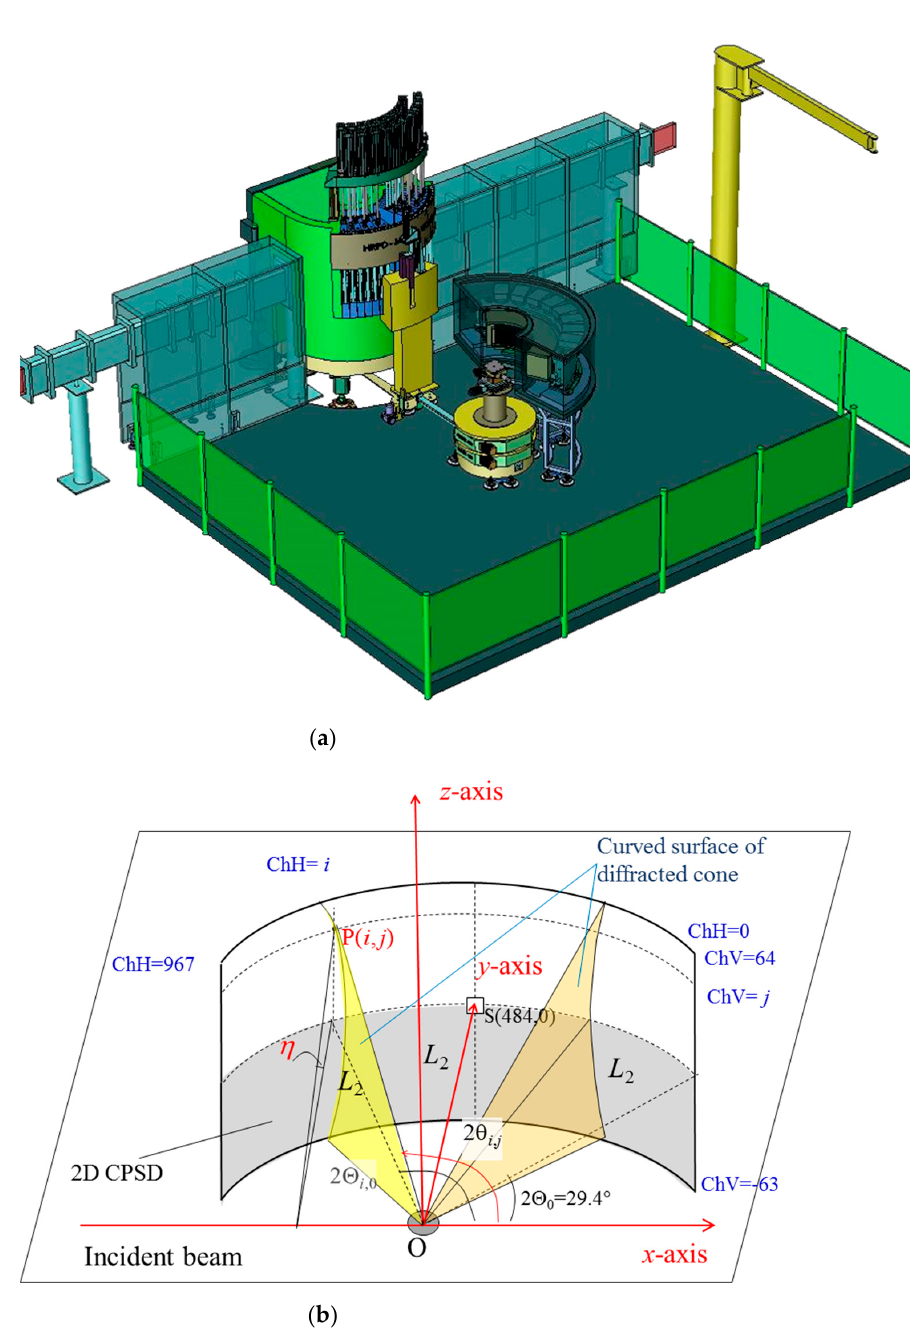
Figure 3. ( a ) Layout of WOMBAT, and ( b ) illustration of a two-dimensional cylindrical position-sensitive detector and the axis convention of an arbitrary pixel P( i , j ) → P( x , y, z ) → P(2 θ , η ) for both Cartesian lab space and angular coordinate systems, here at an offset angle of 2 Θ 0 = 29.4°. ( i , j ) are the channel numbers (ChV, ChH) of an arbitrary pixel position along the vertical and horizontal directions, respectively. The current setting with k 2 = 2.61 Å − 1 and 2 Θ 0 = 29.4° enables us to obtain the best reciprocal space resolution for the overlapping γ -111 and α -110 peaks, while k 1 = 4.08 Å − 1 (see Appendix A) allows accessing more reflections simultaneously. A clear lateral varia- tion in peak intensities appears between the dashed and dotted line areas marked on the